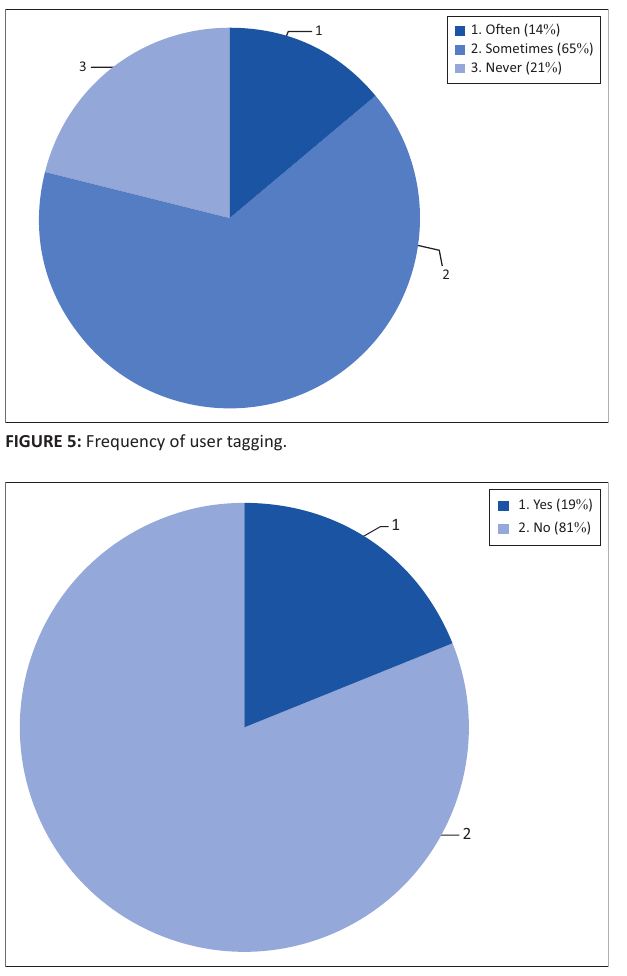
FIGURE 6: User awareness of PoPI.